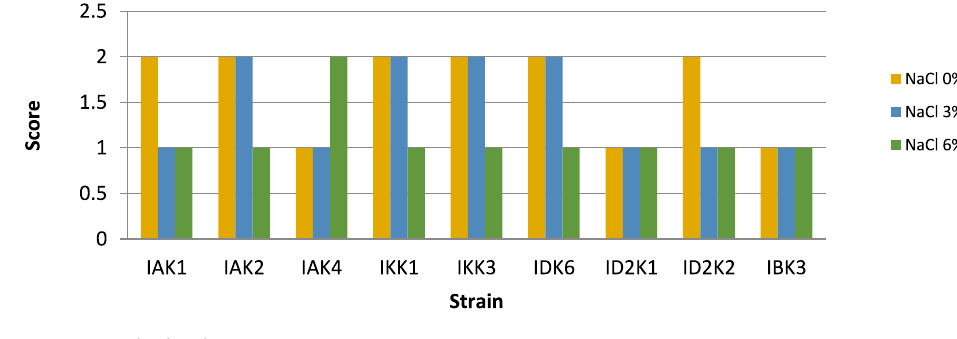
Fig. 1. Bacterial salt tolerant assay Description: Score null = none growth, Score1 = small colony, Score 2 = Large colony,